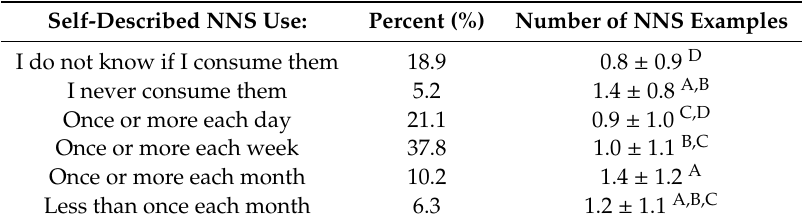
Table 2. Respondents who self-reported avoidance of NNS in the diet provided a greater number of NNS examples from memory in a fill-in-the-blank format. Self-Described NNS Use: Percent